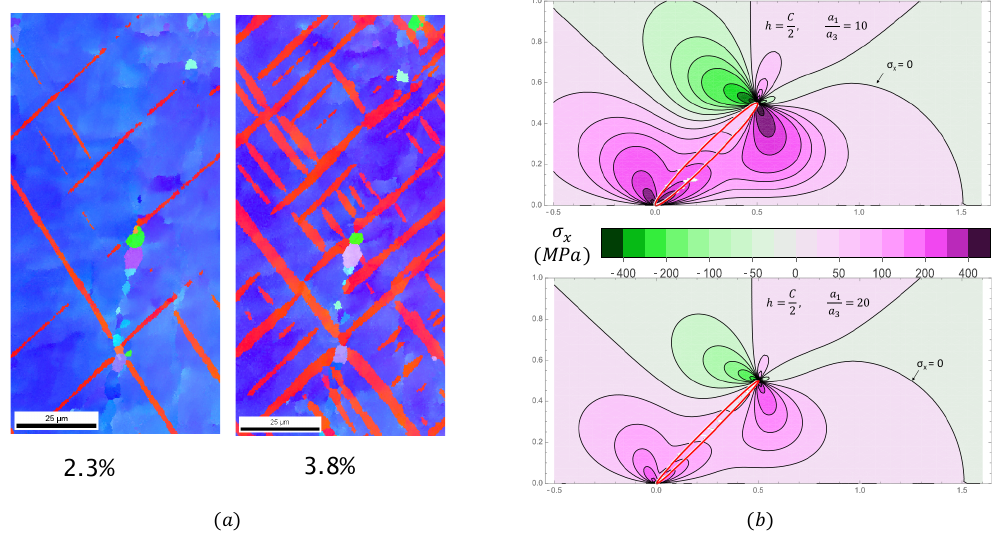
Figure 17. ( a ) Grain experiencing the double { 1012 } twin variant with a characteristic twin spacing in Mg AM30 [221] and ( b ) the stress response ( σ x ) of an ellipsoidal twin in an isotropic, homogeneous, half–infinite domain as obtained from micromechanics–based analytical solution. The twin spacing determined by the zero–stress contour line is a function of twin height, whereas the magnitude of stress relaxed is a function of twin